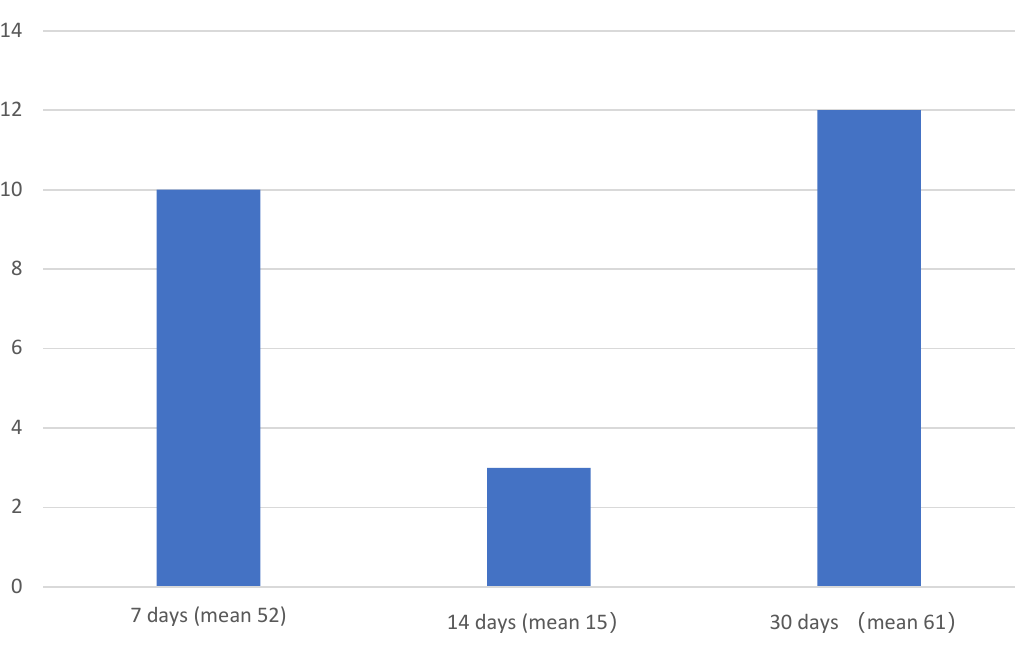
Figure 6. Graphic that shows the means of VEGF expression (blue columns) at 7, 14 and 30 days. The ANOVA test showed a significant statistical di ff erence among the means obtained at 7, 14 and 30 days of treatment ( p -value <